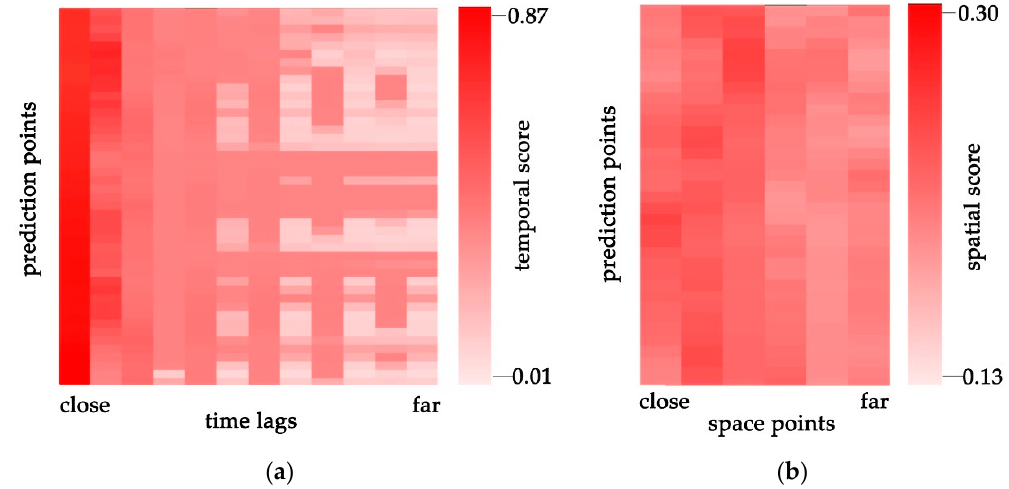
Figure 7. Attention visualization of average score on different prediction points at ( a ) different time